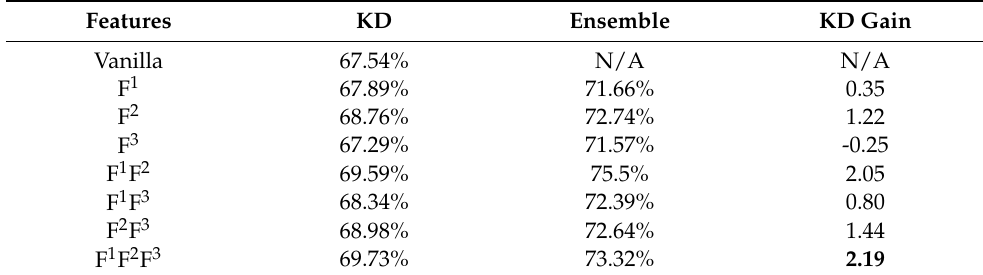
Table 8. Ensembling features.(best results represented in bold).